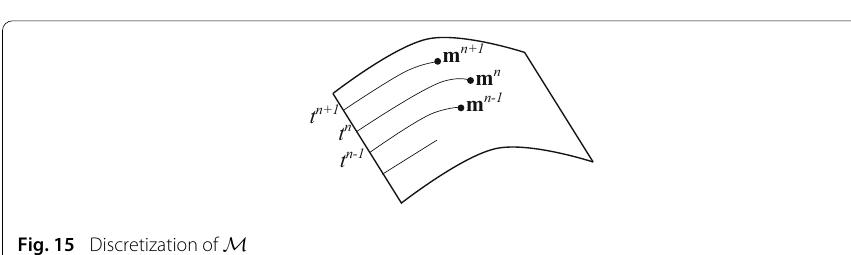
Fig. 15 Discretization of